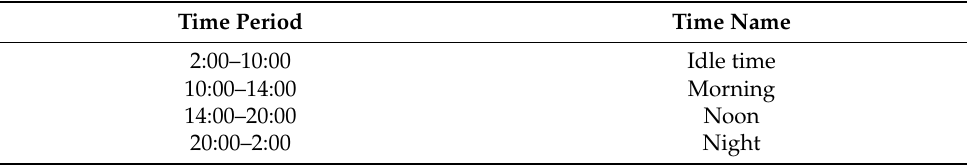
Table 1. Internet time allocation for teachers and